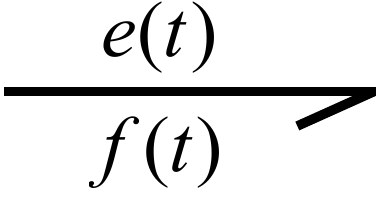
Figure 3. Power bond.